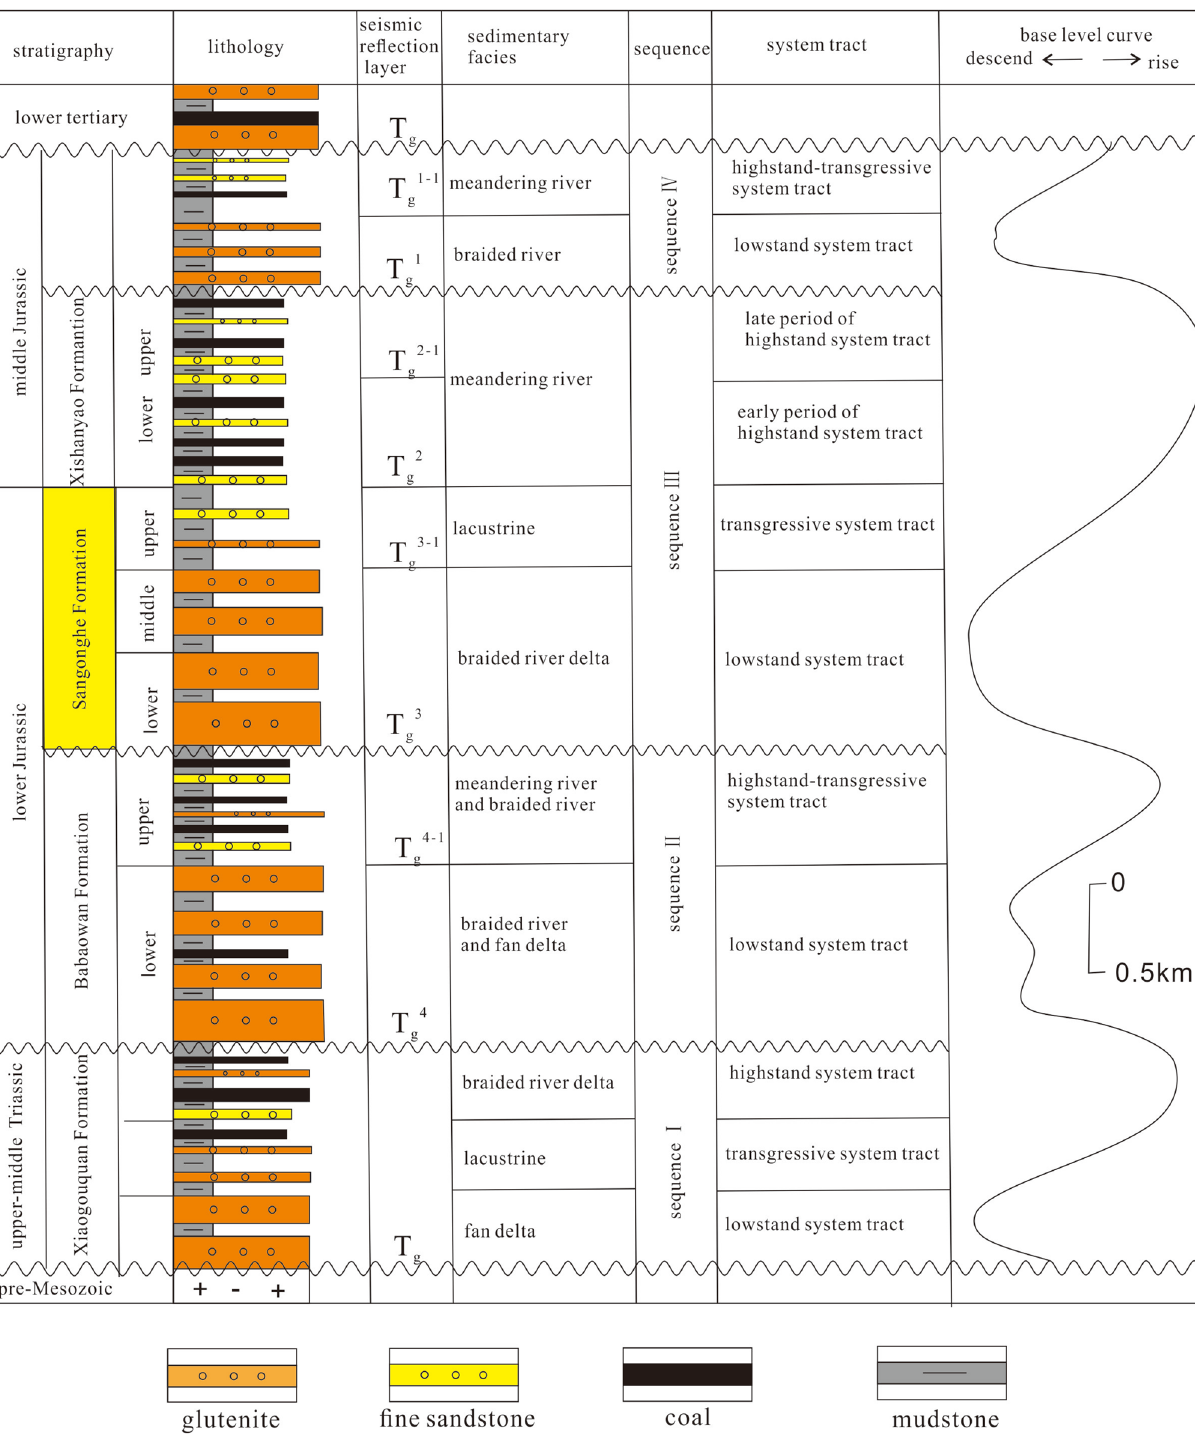
Fig. 2 Mesozoic stratigraphic sequence in the Yanqi